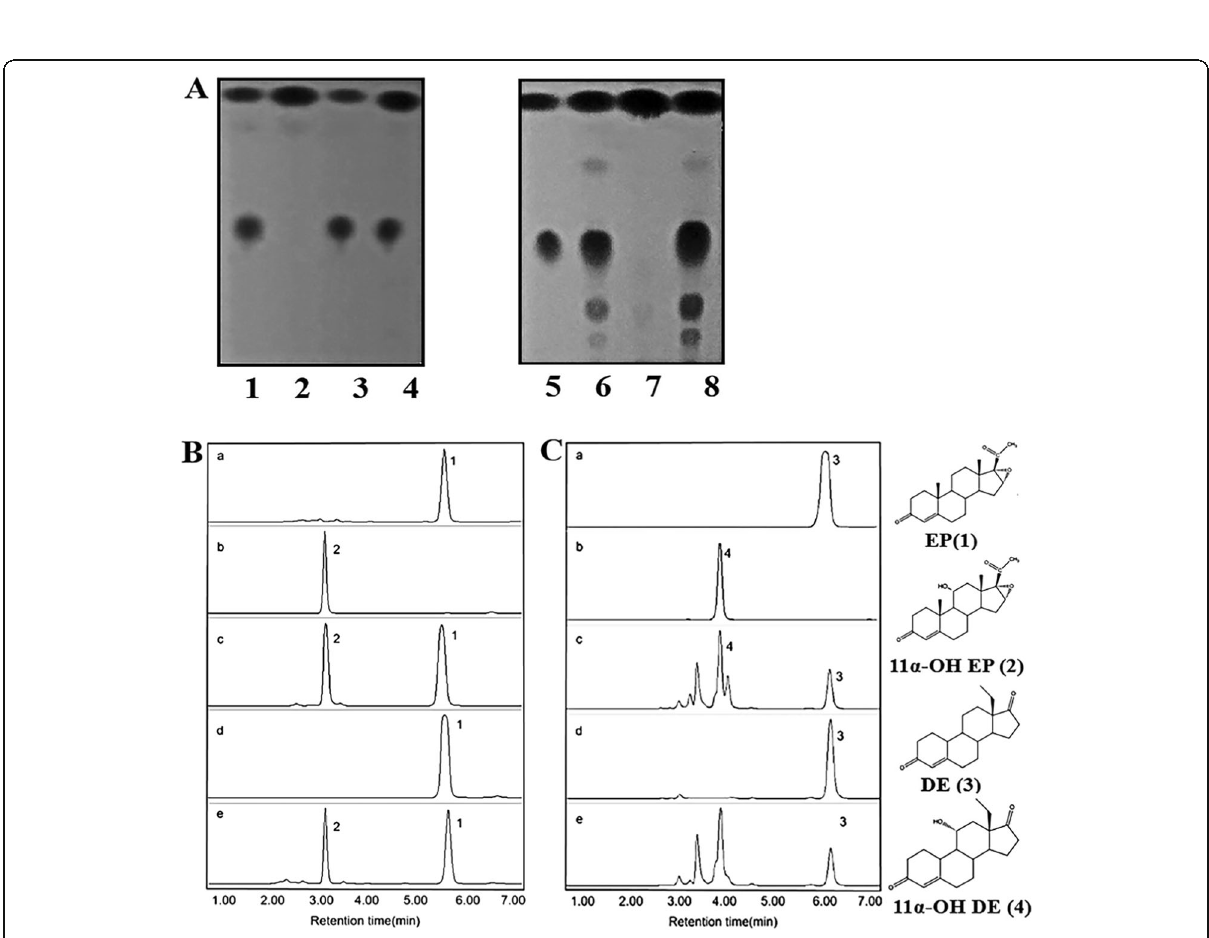
Fig. 5 TLC and HPLC analyses of biotransformation products. a TLC assays: lanes 1 – 4, EP as substrate, petroleum and ethyl acetate (3:2) as the solvent system; lanes 5 – 8, DE as substrate, petroleum and ethyl acetate (1:1) as the solvent system. 1, A. ochraceus TCCC41060; 2, the cyp68j5 mutant; 3, the reconstituted strain; 4, EP and 11 α -OH EP standards; 5, DE and 11 α -OH DE standards; 6, A. ochraceus TCCC41060; 7, the cyp68j5 mutant; 8, the reconstituted strain. b , c HPLC assays: acetonitrile: H 2 O 80:20 (v/v) as the mobile phase, b EP as substrate: EP standard (a), 11 α -OH EP standard (b), transformation products of recipient strain (c), the cyp68j5 mutant (d), and the reconstituted strain (e); c DE as substrate: DE standard (a), 11 α -OH DE standard (b), transformation products of the recipient strain (c), the cyp68j5 mutant (d), and the reconstituted strain